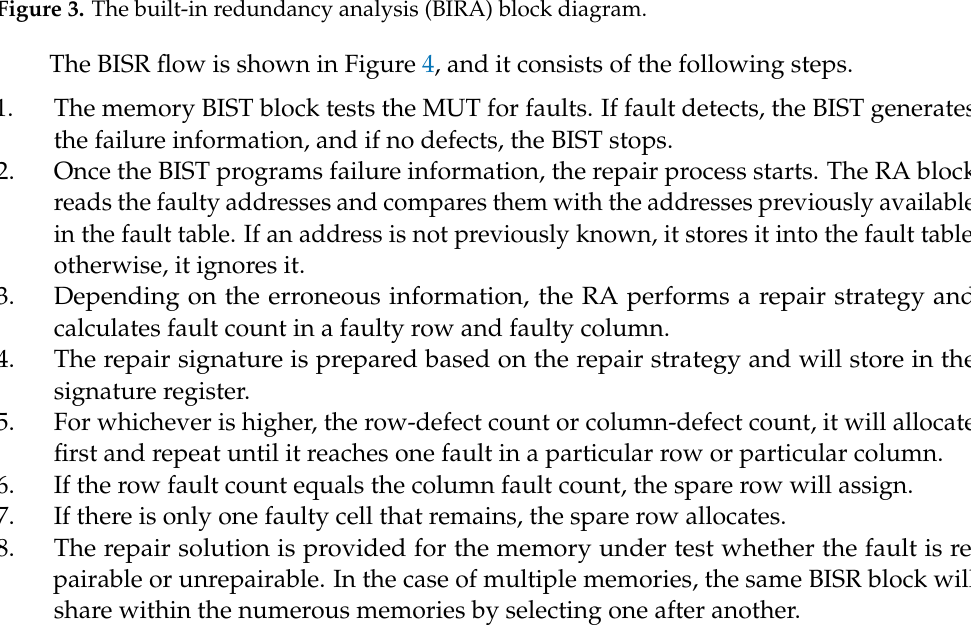
Figure 3. The built ‐ in redundancy analysis (BIRA) block diagram. Figure 3. The built-in redundancy analysis (BIRA) block